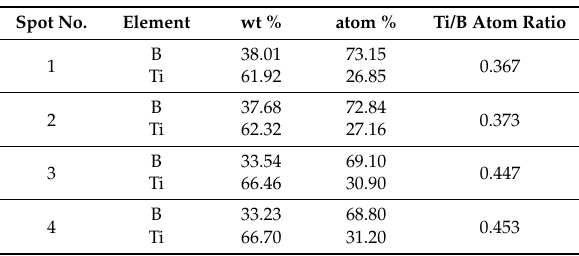
Table 2. The EDS (energy dispersive spectroscopy) analysis results of different regions of samples in Figures 3 and 4.